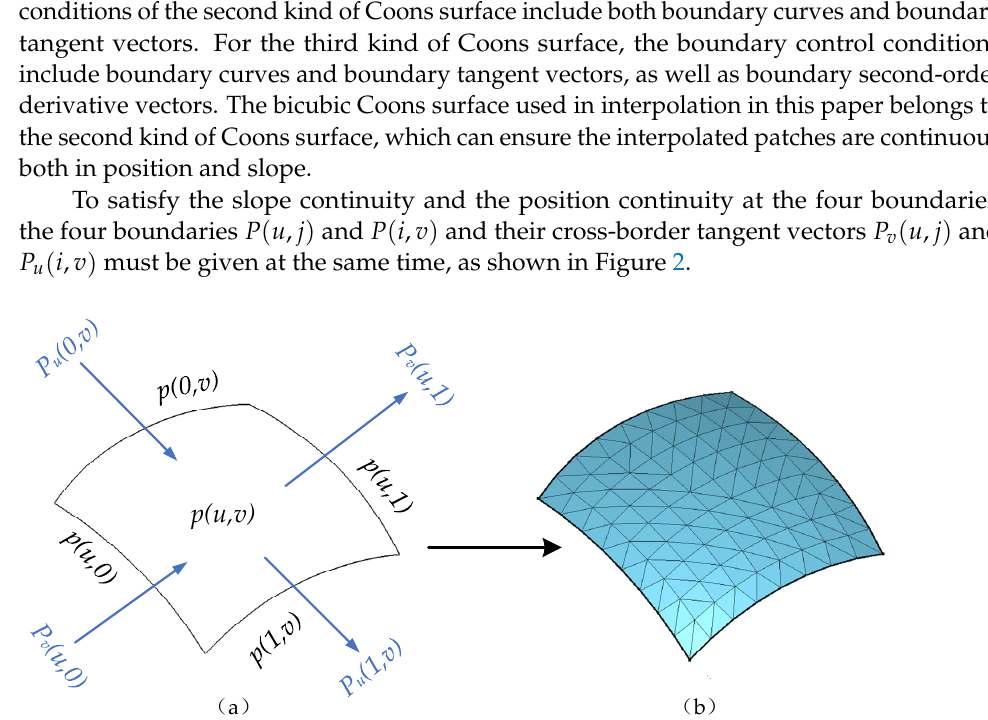
Figure 2. Schematic diagram of the interpolation of the second kind Coons surface: ( a ) boundaries and their cross-border tangent vectors of the surface patch; ( b ) the interpolated surface.